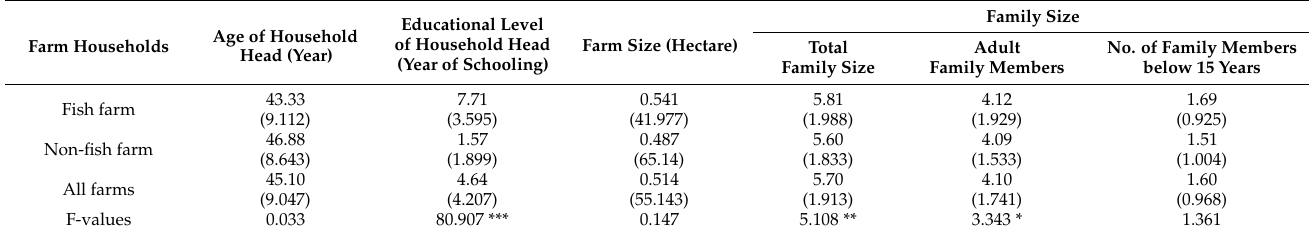
Table 1. Fish and non-fish farm households’